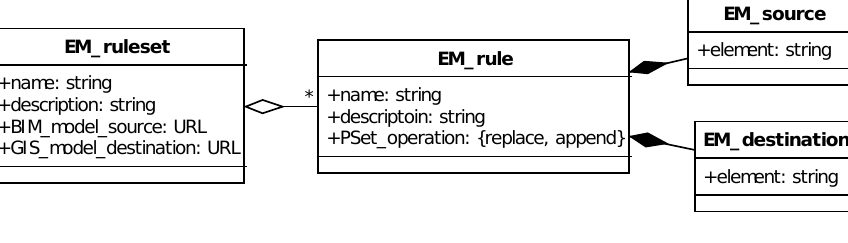
Figure 13. B2G EM concept diagram (UML).